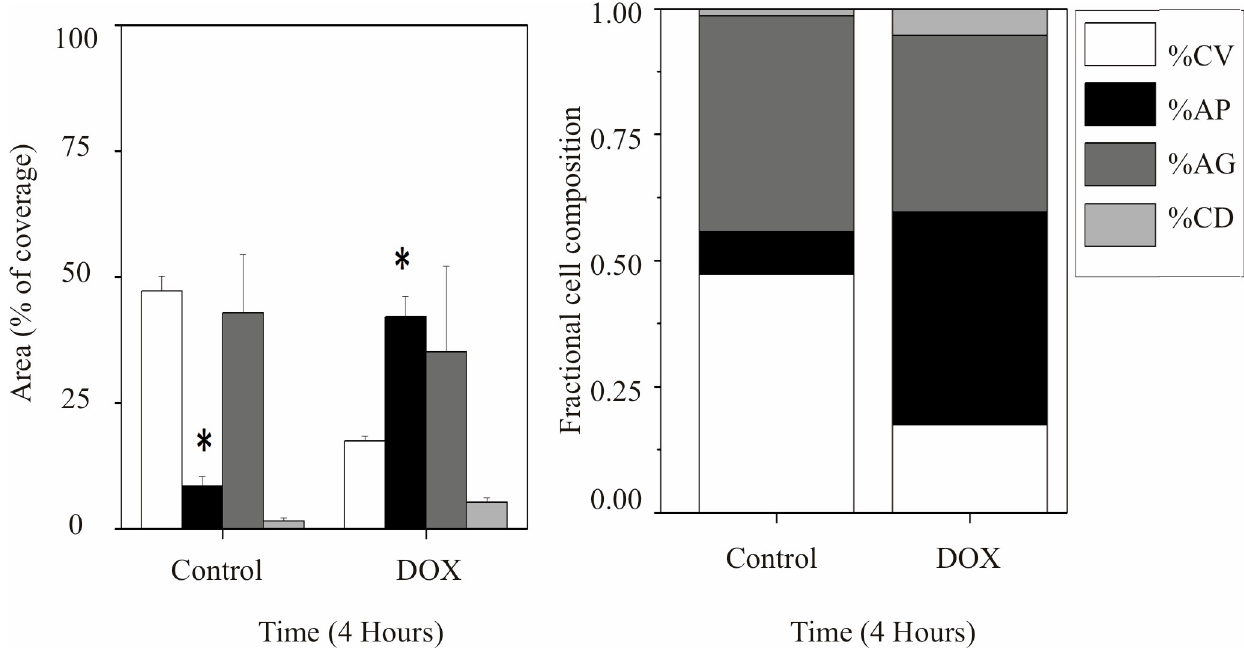
Fig 4. Doxorubicin effect on cells after four hours. Left, the apoptosis process ( AP ) increased significantly with respect to the control. The area covered by viable cells ( CV ) showed a decrease which was not significant in comparison to the control. Right stacked bar graph shows the value of the results in cell fraction composition. ( � ) indicates a significant difference between days among subgroups (p < 0.05).